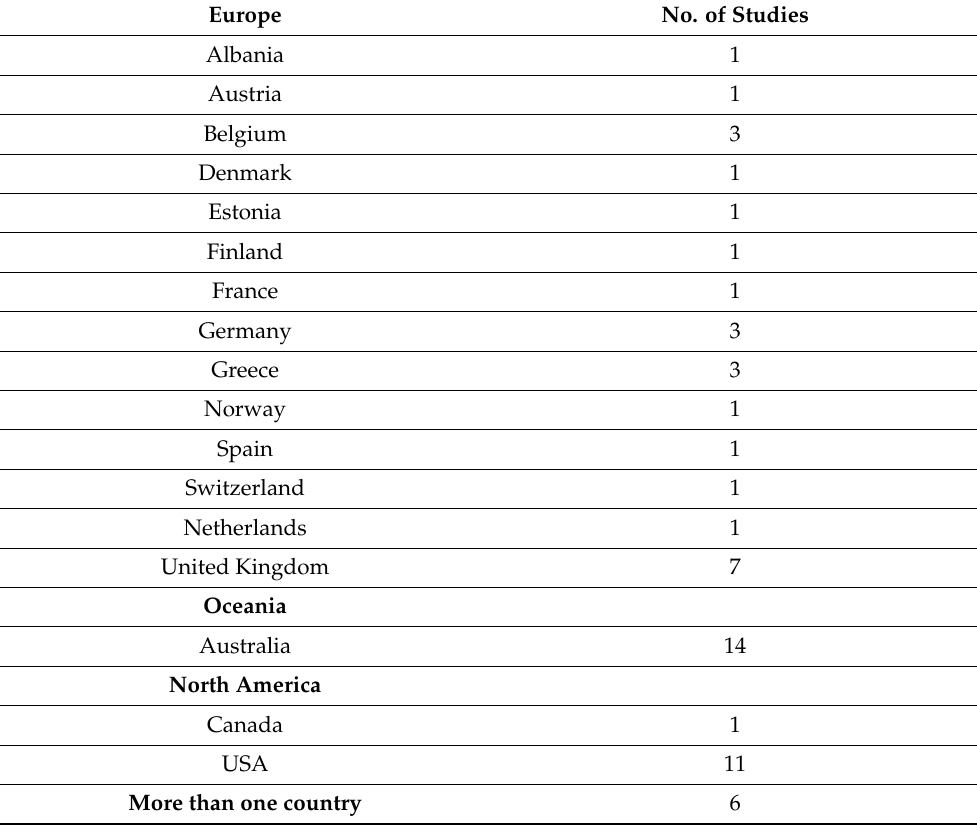
Table 2. Descriptive information about the origin (continent and country) of the included studies. Europe